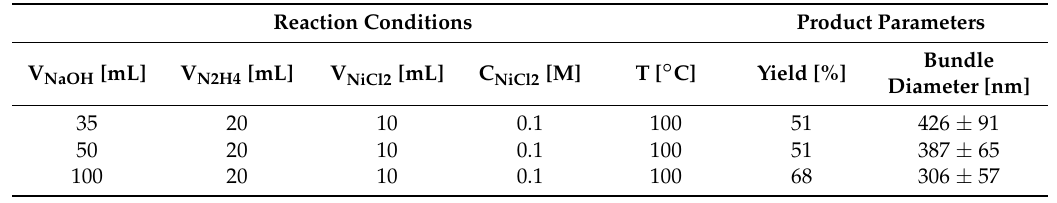
Table 2. The influence of pH on the product parameters.